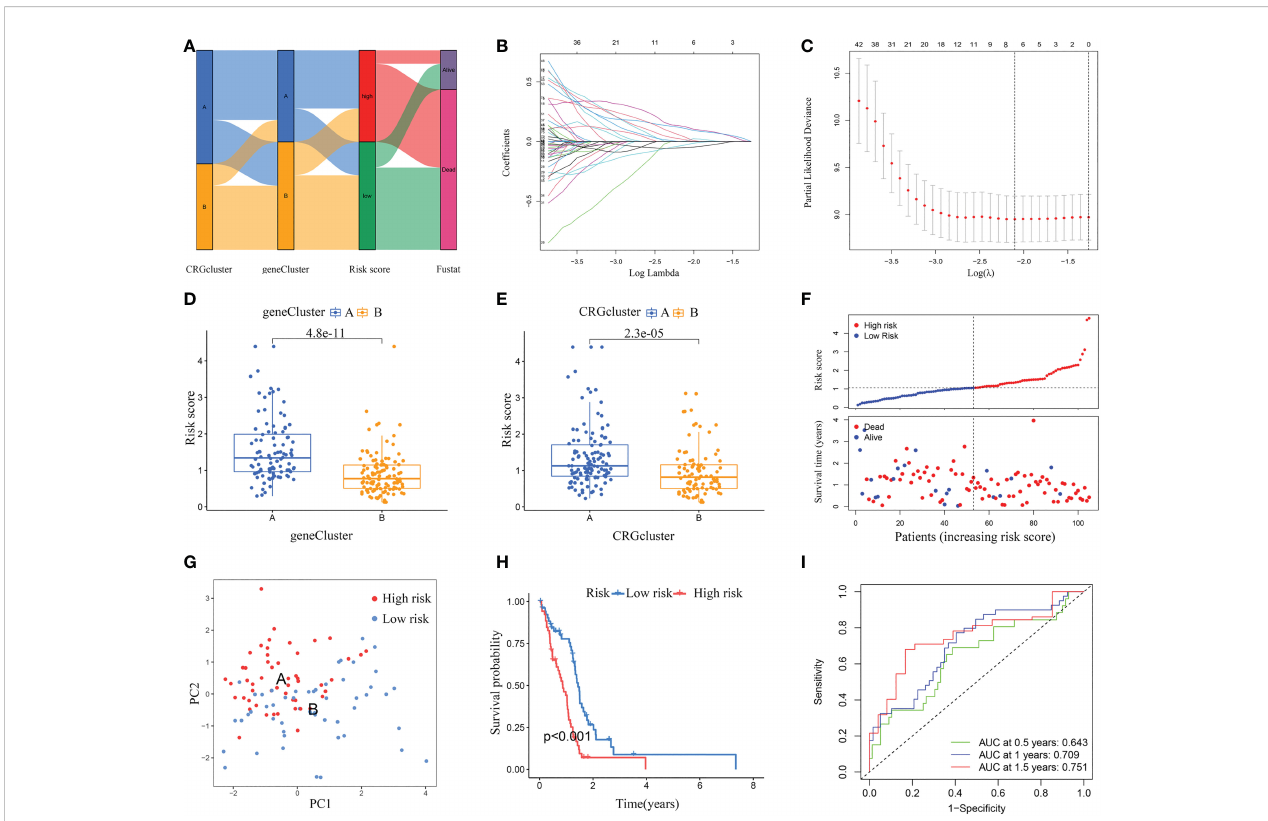
FIGURE 6 Constructed a risk score model in the training set. (A) Alluvial diagram of subtype distributions and prognosis of GBM patients. (B, C) LASSO regression analysis identi fi ed representative candidate prognostic genes and partial likelihood deviance on the prognostic genes. (D) The difference in risk scores between the two gene subtypes. (E) The difference in risk scores between the two cuproptosis subtypes. (F) The ranked dot plot indicates the risk score distribution, and the scatter plot presents the patients ’ survival status. (G) The PCA analysis based on the prognostic signature demonstrated that the patients in the different risk score groups were distributed in two directions. Red and blue dots represent the high-risk group and the low-risk group. (H) Kaplan-Meier curves for OS of the two risk groups (chi-square test, p < 0.001). (I) ROC curves to predict the sensitivity and speci fi city of 0.5-, 1.0-, and 1.5-year survival according to the risk score. ROC, receiver operating